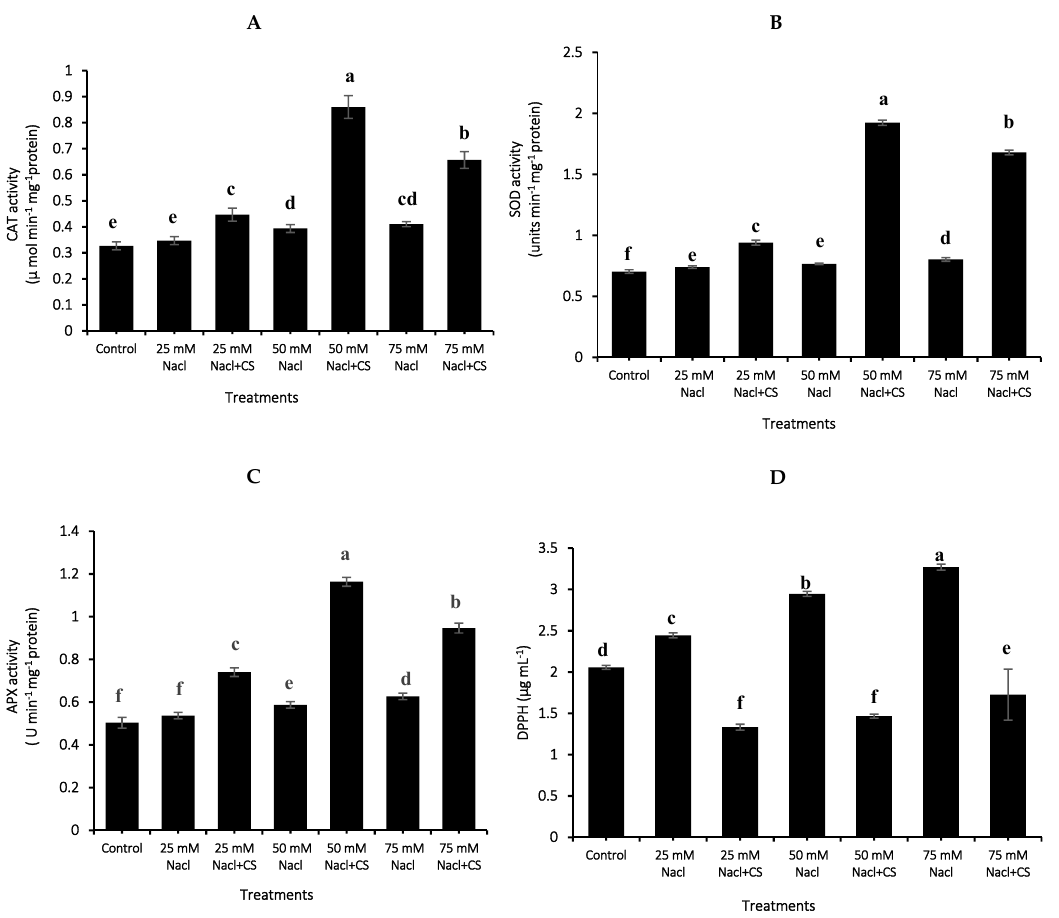
Figure 6. Catalase ( A ), Superoxide dismutase ( B ), Ascorbate peroxidase ( C ) activities and radical scavenging activity measured by DPPH ( D ) of Moringa oleifera exposed to salt stress and sprayed with chitosan (CS) at 1% concentration. Values are means ± SD of two experiments ( n = 6). Columns with different letters are statistically different from each other according to LSD test at p ≤ 0.05.